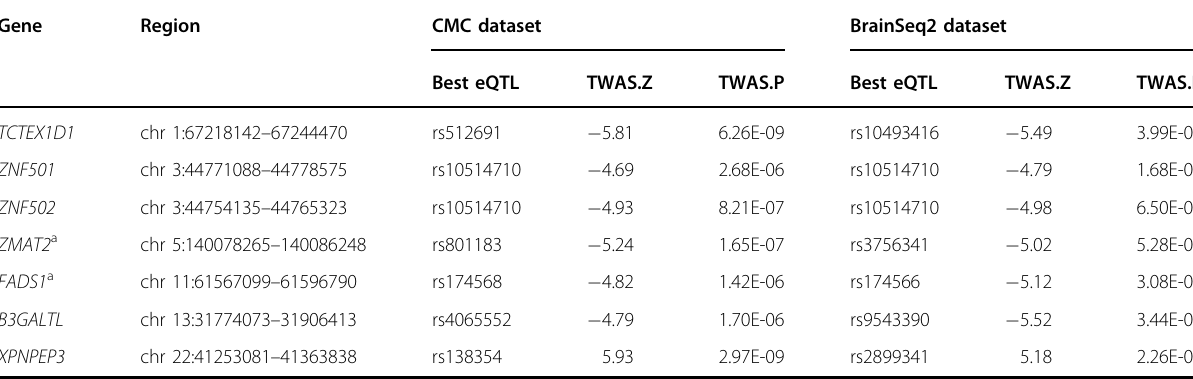
Table 1 Signi fi cant TWAS genes both in CMC and LIBD datasets for depression. Gene Region CMC dataset BrainSeq2